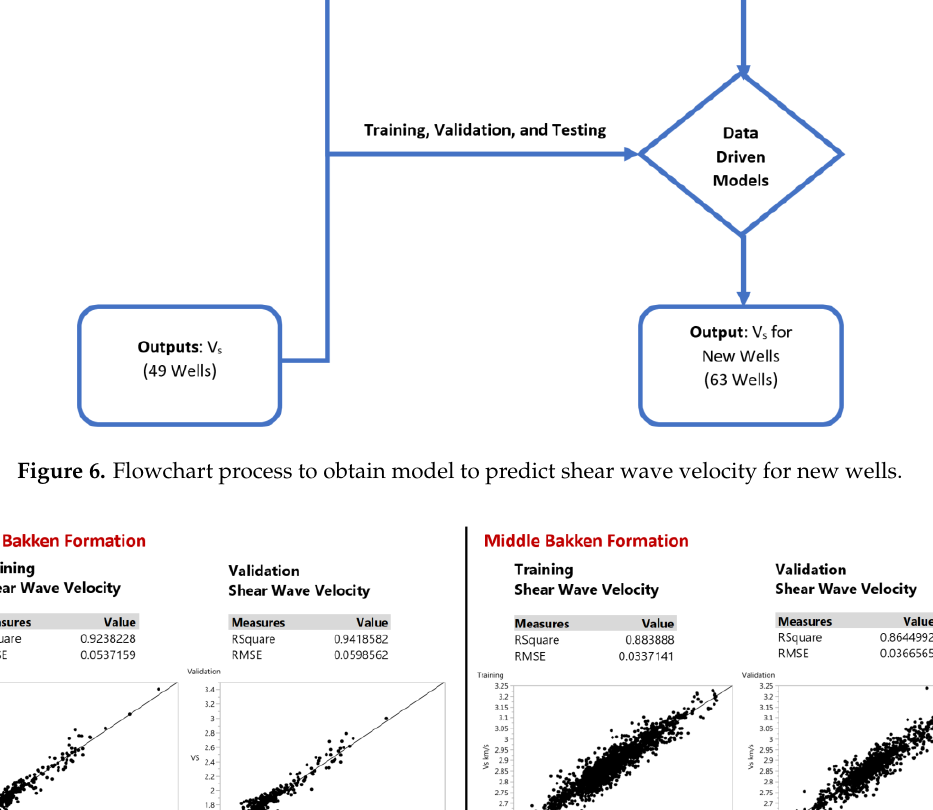
Figure 7. Prediction of shear wave velocity using ANN with its training and validation set for ( a ) the Upper Bakken Formation ( b ) Middle Bakken